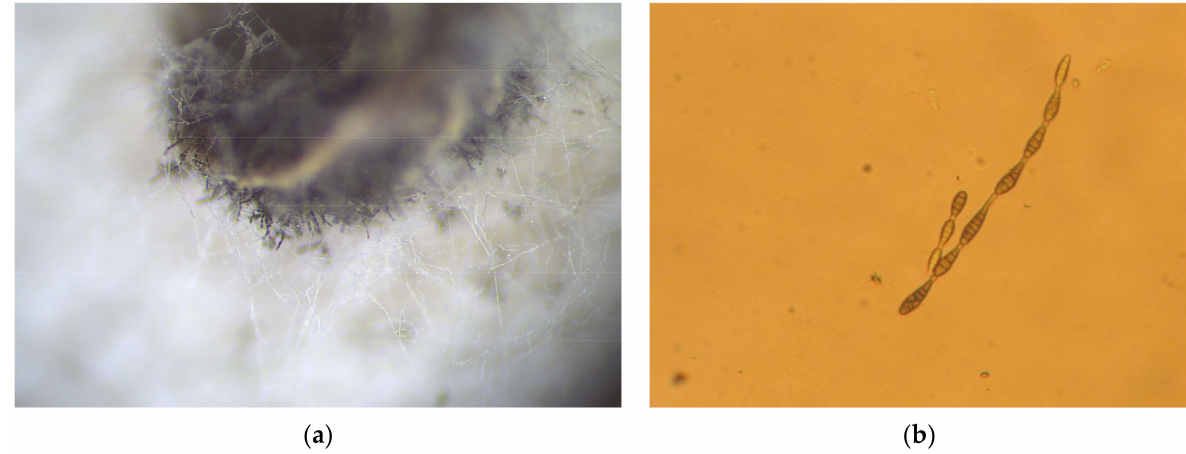
Figure 4. Alternaria alternata on carrot seeds ( a ) and spores ( b ).